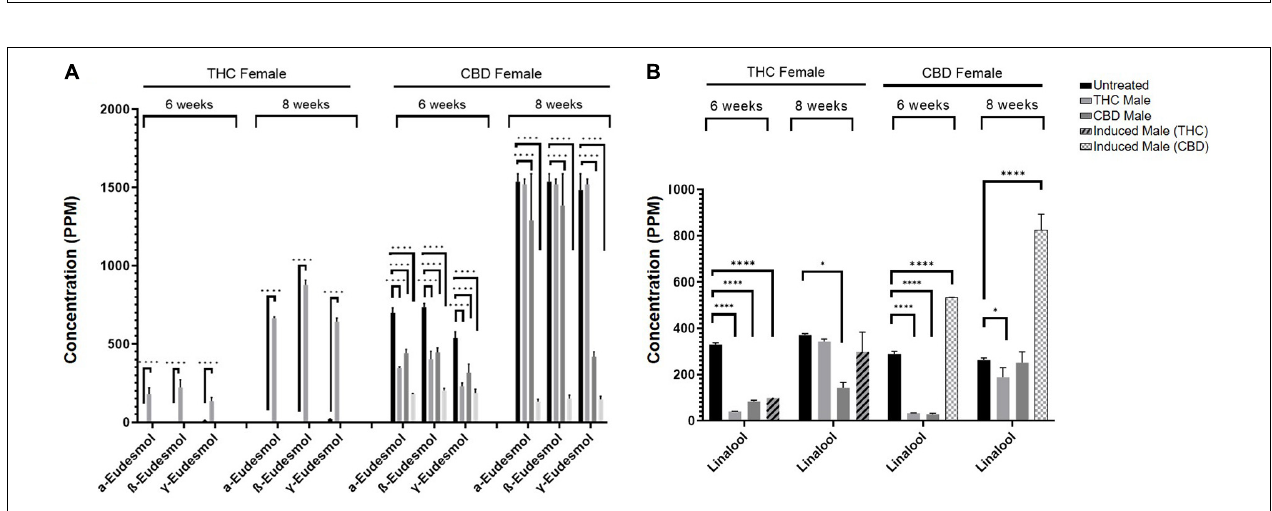
FIGURE 6 | Specific terpenoids are increased following fertilization. (A) α -, β -, and γ -Eudesmol and (B) Linalool concentrations in THC-rich and CBD-rich females at 6-weeks and 8-weeks after fertilization ( n = 2–3, except THC-female fertilized by induced male (THC) at 6 weeks). Statistically significant differences between treatments and control (unfertilized) were calculated by two-way ANOVA followed by Dunnett’s multiple comparison test (* p ≤ 0.05; **** p ≤ 0.0001).